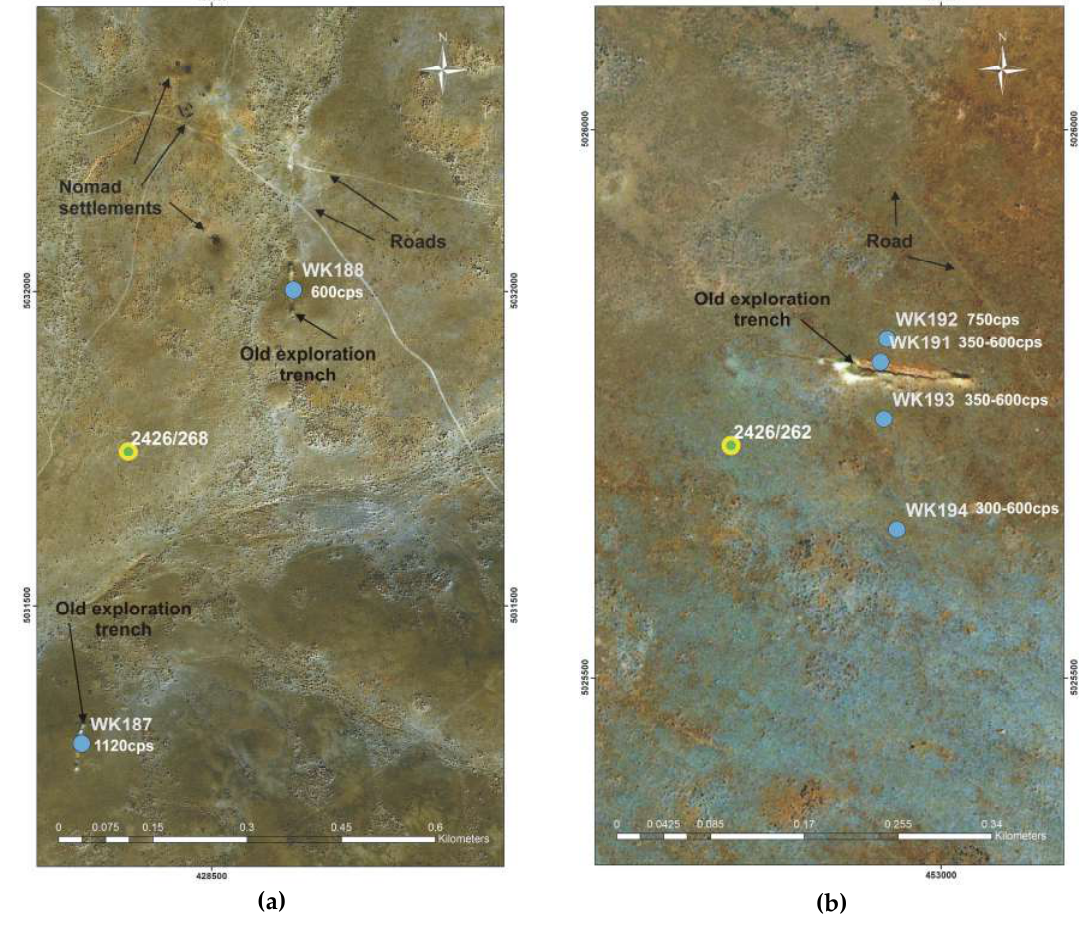
Figure 9. ( a ) Area of historic anomaly 2426 / 268 with recent observation points (blue dots) and nomadic settlement near sources of high radioactivity. Raster basis: SASPlanet ESRI ArcGIS Imagery; ( b ) area of historic anomaly 2426 / 262 with recent observation points (blue dots) and roads near sources of high radioactivity. Raster basis: SASPlanet ESRI Arc GIS Imagery.